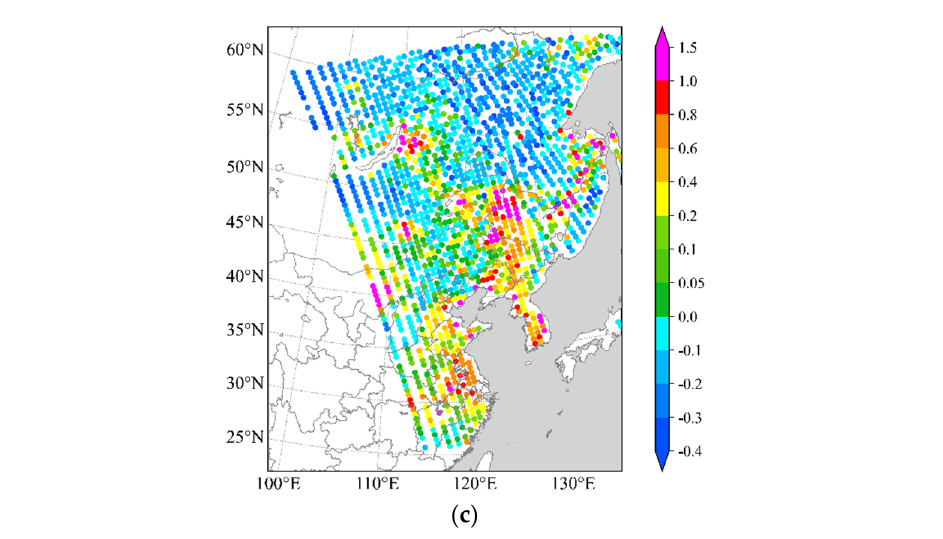
Figure 5. Scatterplots of the numerator (horizontal axis) and denominator (vertical axis) of the AMSU-A cloud index from NOAA-19 over East Asia at ( a ) 0600 UTC 26 June and ( b ) 0600 UTC 28 June 2019, where the colors represent the matched MODIS cloud classification products. The solid black line on the left in ( a , b ) is the fitted line for observations with the A index less than 0.1, and the solid black line on the right is the fitted line for the remaining observations. In order to ensure the stability of the results, one month of AMSU-A observations were used to determine the thresholds of A index . Figure 6 shows the fitted slope of the denominator and numerator of the A index for different thresholds, in which the A index was calculated from AMSU-A observations of NOAA-19 over land areas of East Asia from 0000 UTC 15 June to 1800 UTC 15 July 2019. As can be seen from the figure, the slope for data with the A index bigger than the threshold (black curve) increased slowly with the threshold value increasing to 0.14, and then basically stayed the same. However, for data with the A index less than the threshold (red curve), the slope increased rapidly before the threshold value reached 0.02, and then held steady from 0.02 to 0.1, after which it kept increasing and eventually got close to the black dotted curve. When the threshold value was less than 0.02, there were fewer clear-sky observations with the A index less than the threshold, so the absolute value of the fitted slope was large and increased rapidly. When the threshold value was in the range from 0.02 to 0.1, the data included by respecting the A index less than the threshold were mostly the same clear-sky observations, so the fitted slope stayed nearly the same. However, after the threshold value exceeded 0.1, the slope increased steadily and eventually got close to the slope of the observations in the cloudy area. This means